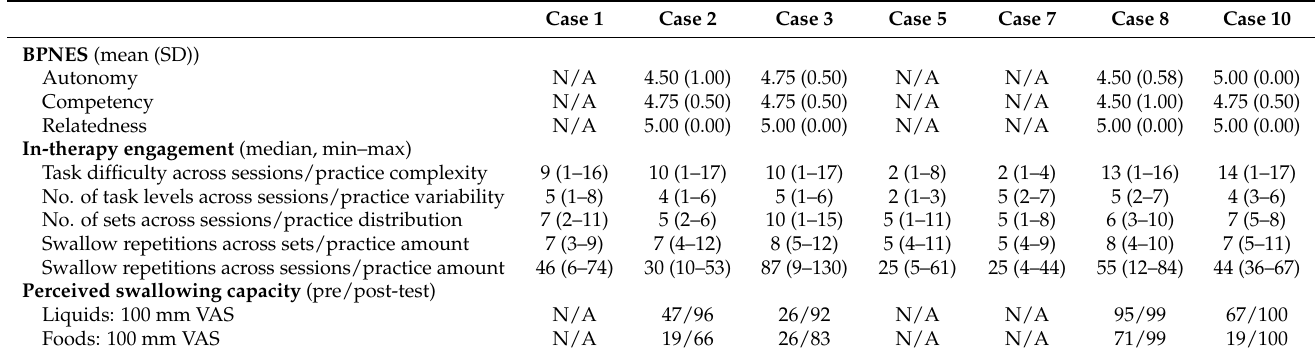
Table 6. Descriptive information on the putative mediators of change in the ACT-ING program.